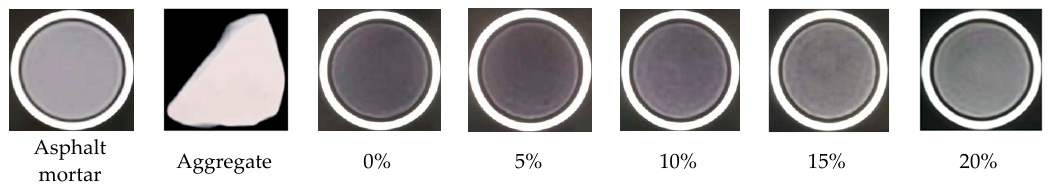
Figure 4. CT Images of Each Part. Table 7. CT Values of Each Part.